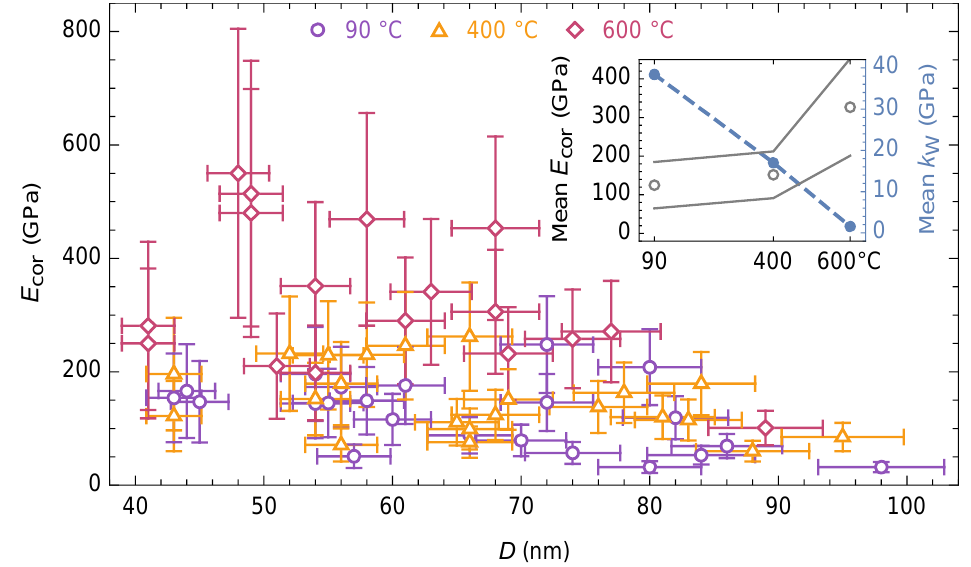
Figure 6. The Young’s modulus 𝐸 cor versus nanobridge outer diameter 𝐷 after drying at 90 °C and after heat treatment at 400 and 600 °C. The inset shows the weighted average value of Young’s modulus versus the treatment temperature (colored areas mark one standard deviation), as well as the average value of the elastic foundation stiffness 𝑘 W .